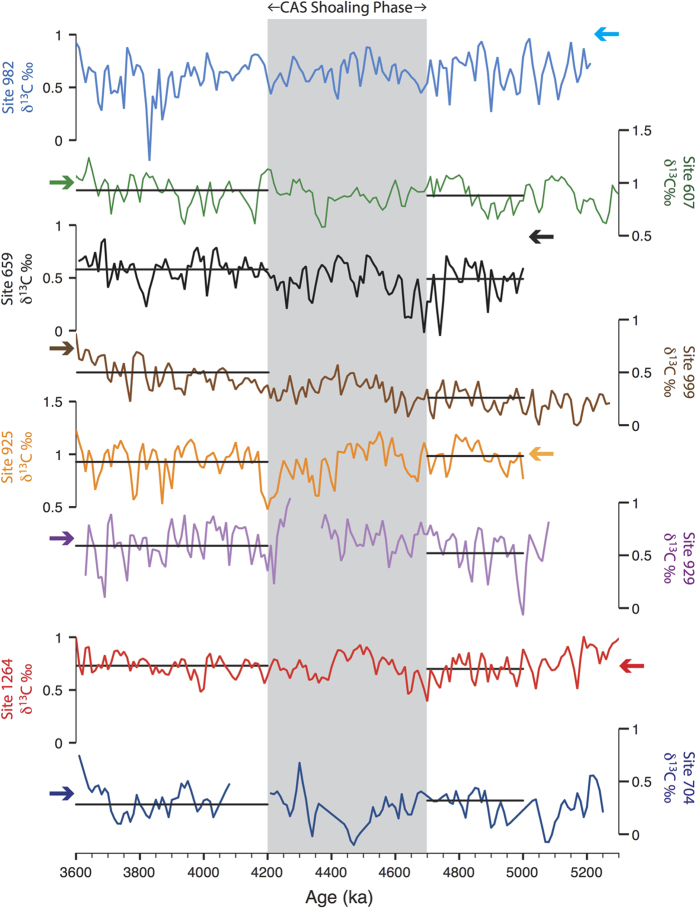
Time series of δ13C data (‰ vs Vienna Pee Dee Belemnite) from all sites shown in Fig. 1.Data has been resampled at common 10 kyr time steps (linear integration). Horizontal black lines show average δ13C values for the time slice intervals 5.0–4.7 Ma (Pre CAS shoaling) and 4.2–3.6 Ma (Post CAS shoaling). Arrows indicate approximate modern δ13C values for each site location48. Note that data for Site 607 has been resampled at 10 kyr intervals, as is available from32, while data from Site 704 prior to 4.2 Ma is displayed as symbols in order to highlight the low resolution and stratigraphic uncertainty. Data references are given in Table 1.